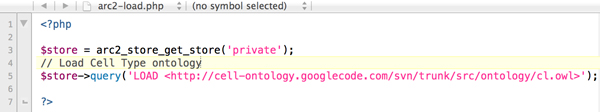
Code snippet to load external ontologies. The two lines of code are required to connect and load the CL ontology.